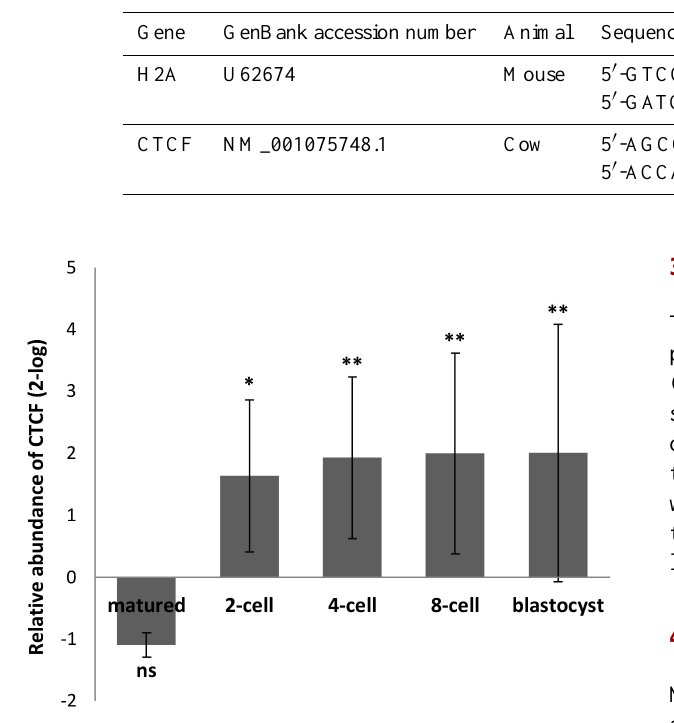
Figure 1. Relative abundance of CTCF in various stages of bovine embryonic development. Data are shown as folds of transcript levels (2-log) ± SE. ns: not significantly different from immature oocyte ( P >0.05), * and **: significantly different from immature oocyte ( P <0.05 and P <0.01,